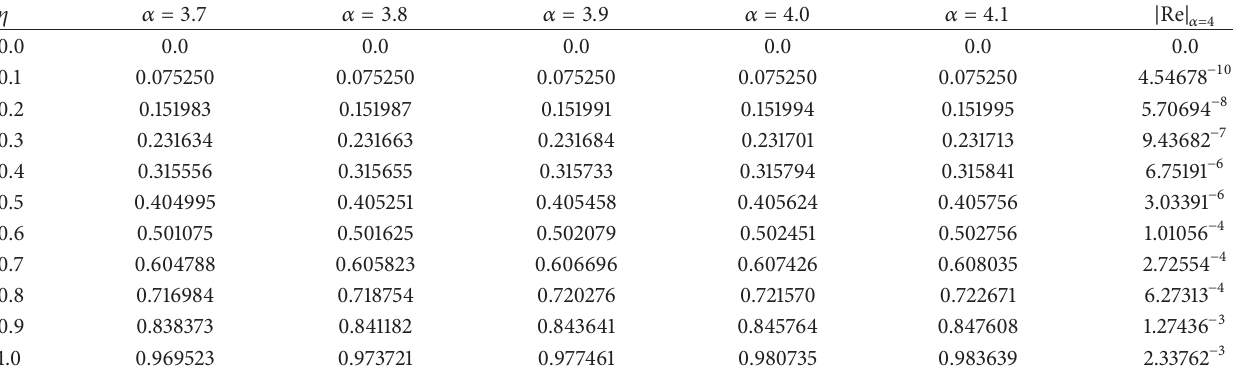
Table 6: Solutions for different values of 𝜂 and 𝛼 at 𝑅 = 0.5 and 𝛾 = 1 in case of slip boundary.